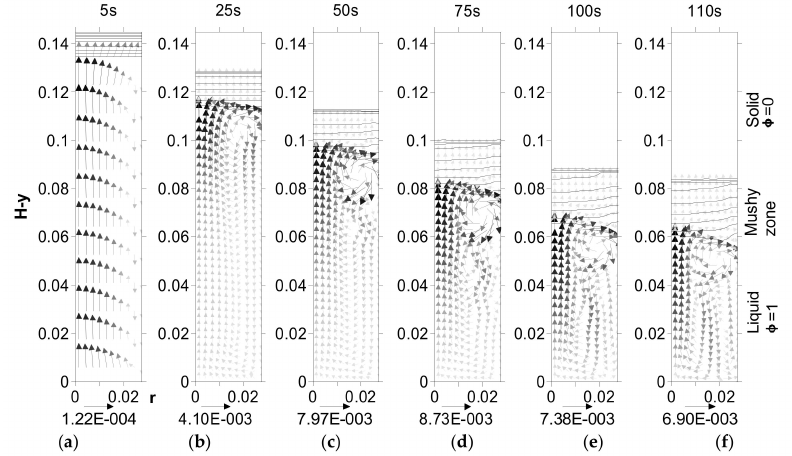
Figure 11. Development of fluid flow velocity (m.s − 1 ) during solidification simulation S6 with effect of undercooling for t = ( a ) 5 s; ( b ) 25 s; ( c ) 50 s; ( d ) 75 s; ( e ) 100 s and ( f ) 110 s. The magnitudes of maximum velocities are presented at the bottom of ( a – f ),